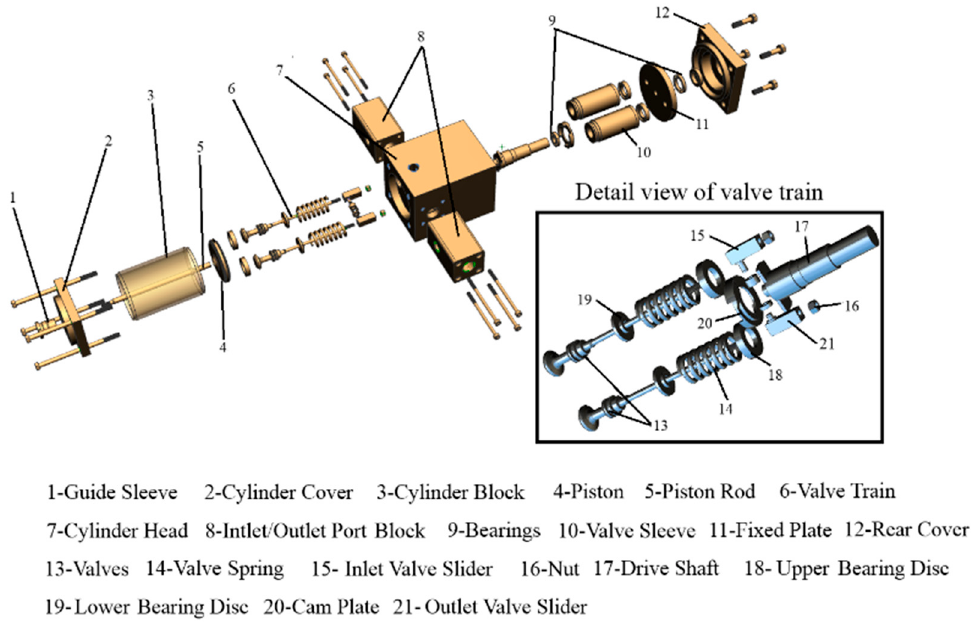
Figure 3. Exploded view of the FPE configuration (small fasteners are omitted for clarity). Table 1. The main construction parameters of FPE.